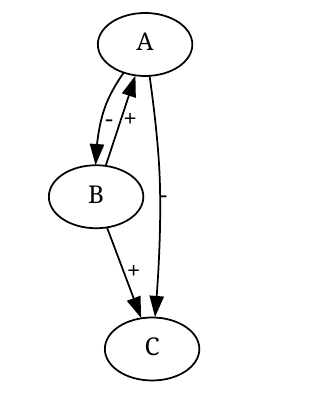
Figure 1 – Influence graph of the example BN for